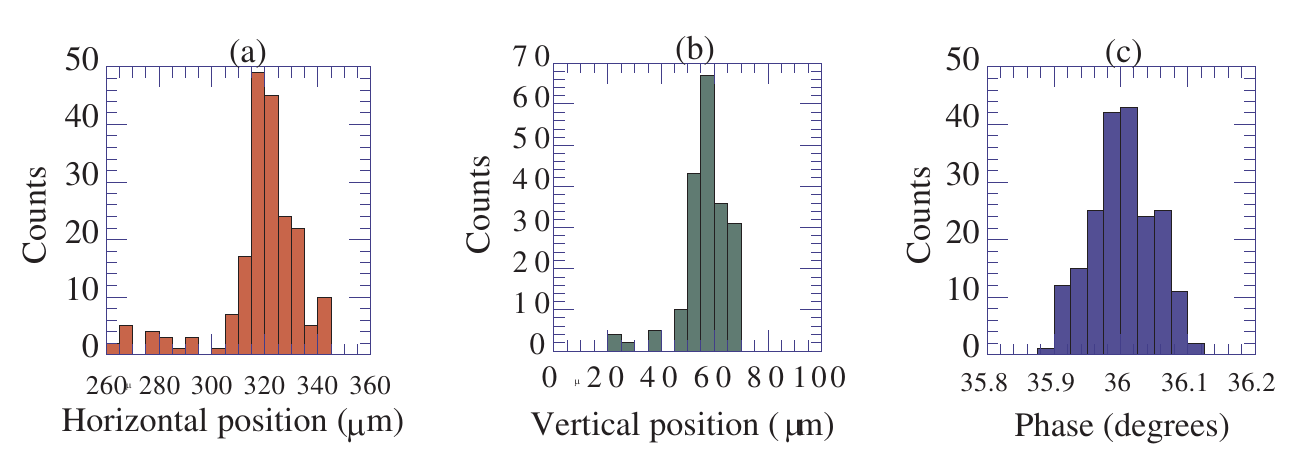
FIG. 4. (Color) Reproducibility of the measured beam positions; (a) the horizontal position, av (cid:5) 318 : 6 (cid:11) m , rms (cid:5) 15 : 5 (cid:11) m , (b) the vertical position, av (cid:5) 59 : 9 (cid:11) m , rms (cid:5) 9 : 1 (cid:11) m , (c) the beam phase, av (cid:5) 36 : 00 (cid:12) , rms (cid:5) 0 : 05 (cid:12)